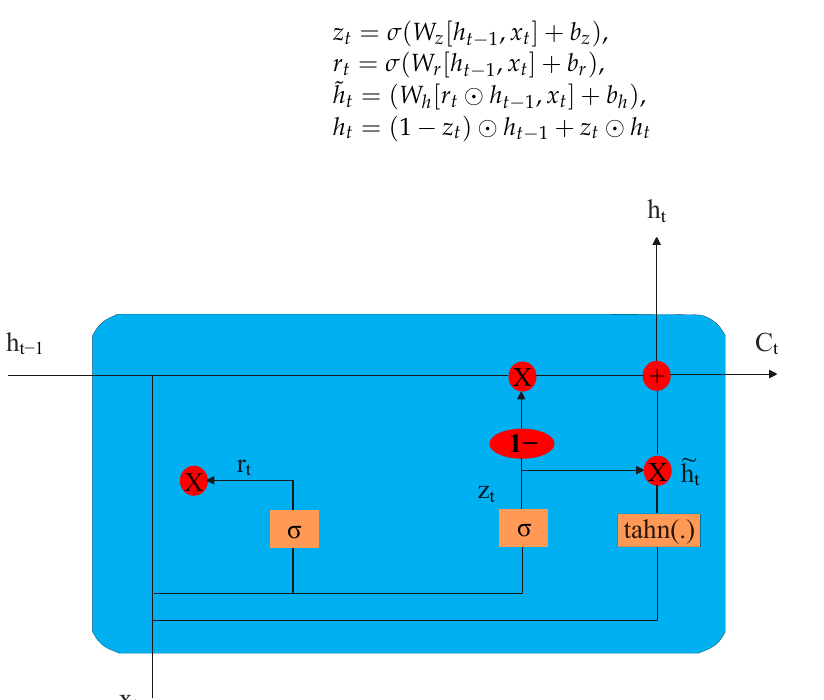
Figure 7. Typical GRU unit architecture